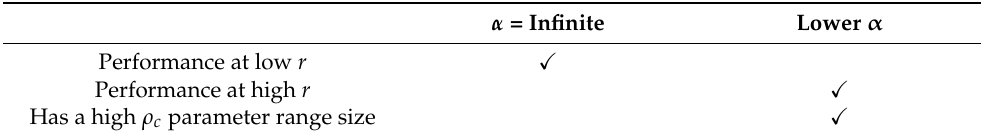
Table 1. Performance of different α